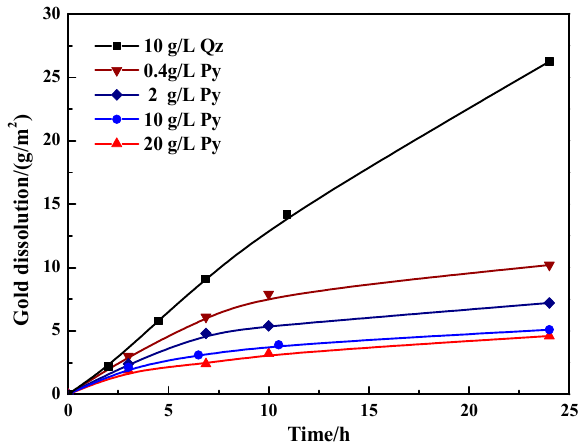
Figure 5. Variation of the gold dissolution with time during thiosulfate leaching of gold in the presence of pyrite and quartz. Mineral content: 0.4, 2, 10 and 20 g/L pyrite; 10 g/L quartz. of pyrite and quartz. Mineral content: 0.4, 2, 10 and 20 g/L pyrite; 10 g/L